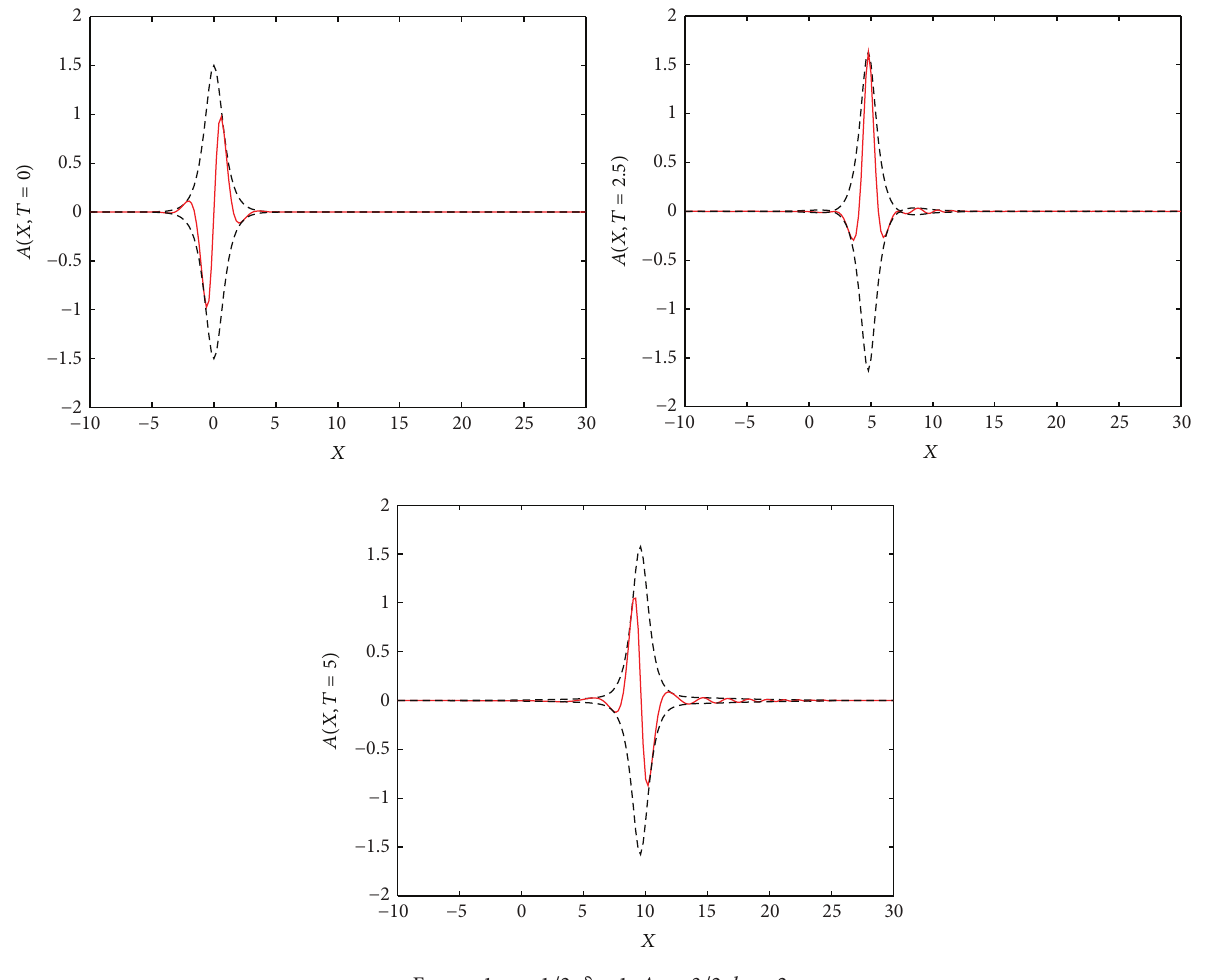
Figure 1: 𝛼 = 1/2 , 𝛿 = 1 , 𝐴 0 = 3/2 , 𝑘 0 = 2